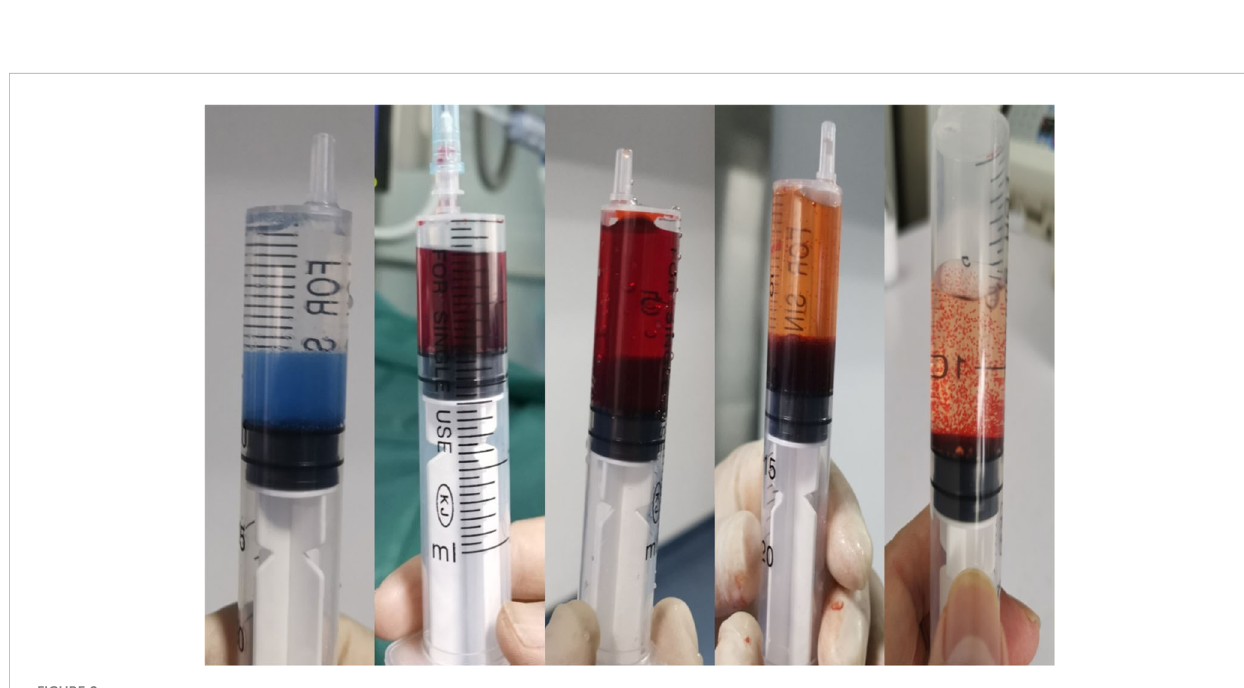
FIGURE 2 The loading process of epirubicin in CalliSpheres drug-loaded